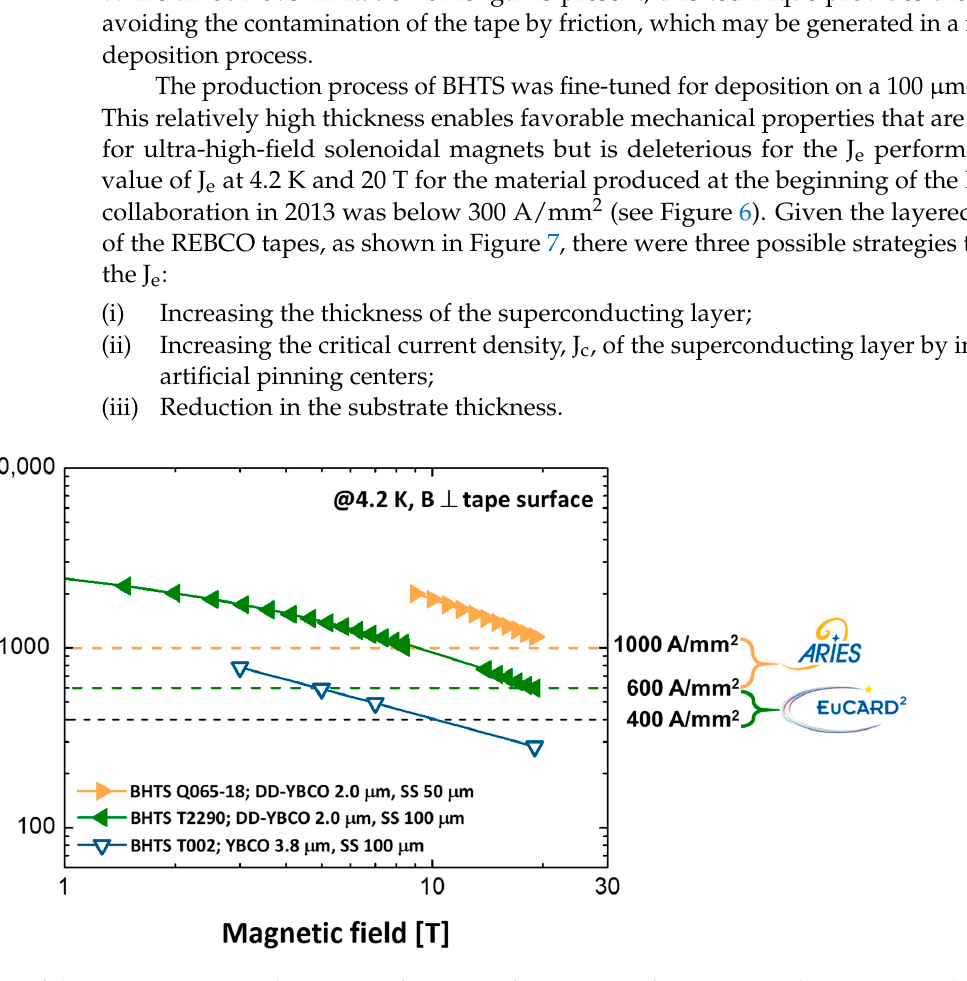
Figure 6. Evolution of the engineering critical current performance of YBCO tapes from BHTS and EuCARD2 and ARIES J e targets. J e (B) is measured at 4.2 K in a perpendicular orientation for three tapes: T002, produced at the beginning of EuCARD2; T2290, produced during EuCARD2; and Q065-18, produced during ARIES.